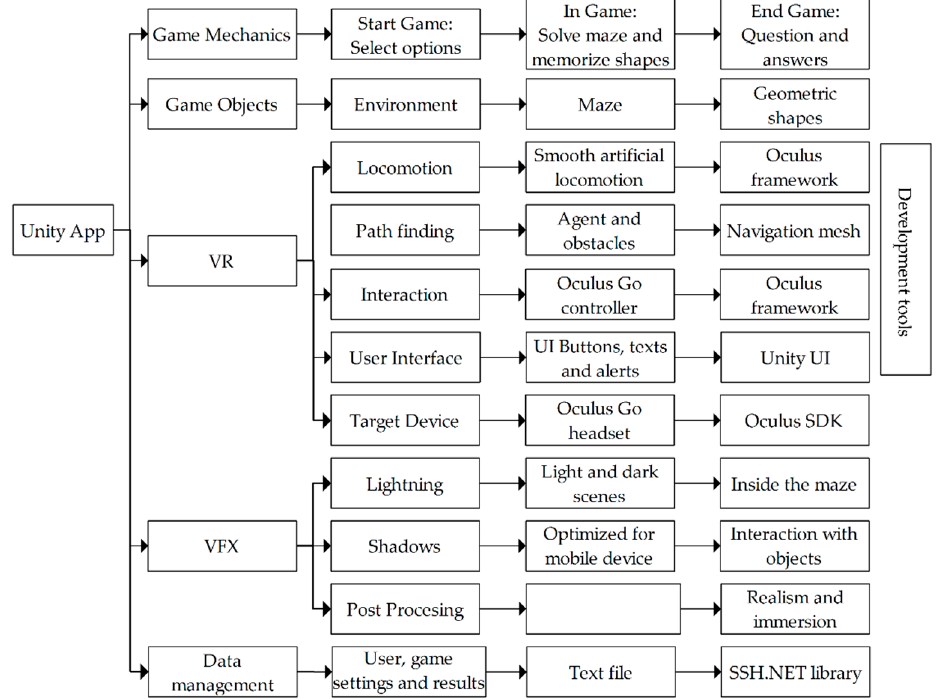
Figure 6. Developed elements of the virtual reality application.